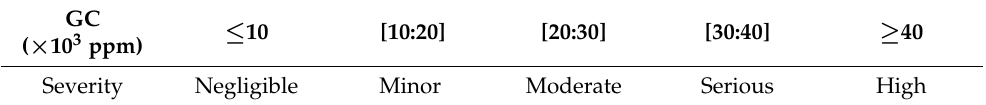
Table 7. Threshold limit values for